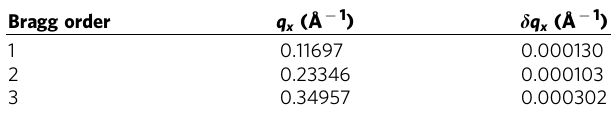
Table 1 | Bragg peak